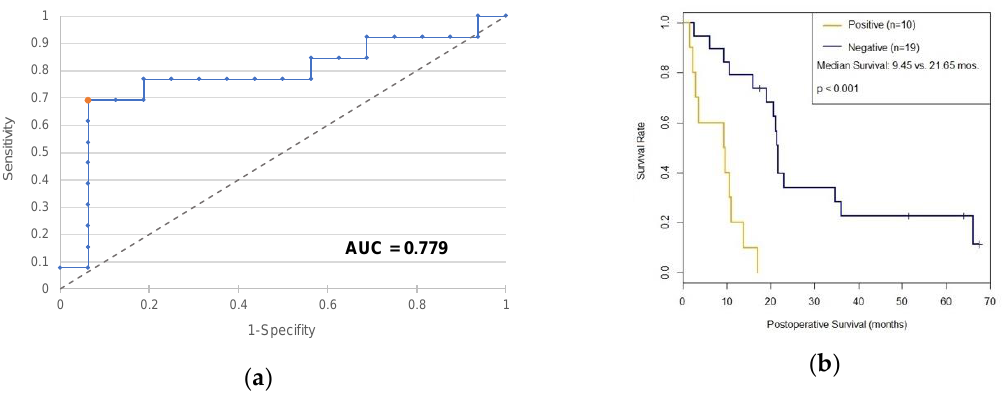
Figure 3. ( a ) ROC curve of a prognostic test based on c-Met. ( b ) Survival analysis according to Kaplan–Meier as a function of c-Met status using >990 as cutoff. Non-informative censors are marked as a dash.